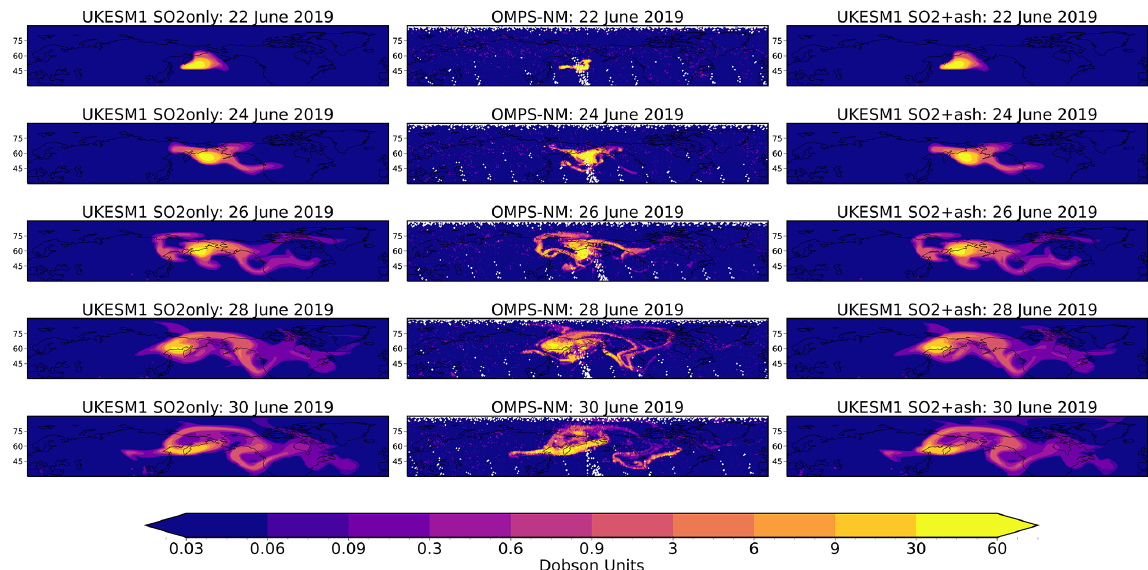
Figure 1. Geographic evolution of column-integrated SO 2 plume in Dobson units (DU) derived from the OMPS-NM lower-stratospheric profile (centre), UKESM1 SO2only (left), and SO2 + ash (right) for the period 22–30 June 2019. We remove the long-term background SO 2 burden derived from OMPS-NM for the years 2013–2018 from those for 2019 to provide a stratospheric perturbation for the observations. Similarly, we remove the impacts of background stratospheric aerosol from the model simulations by subtracting the stratospheric sulfate burdens from the CNTL simulation from those for SO2only and SO2 + ash. The OMPS-LP background and CNTL SO 2 burden are shown in Fig.